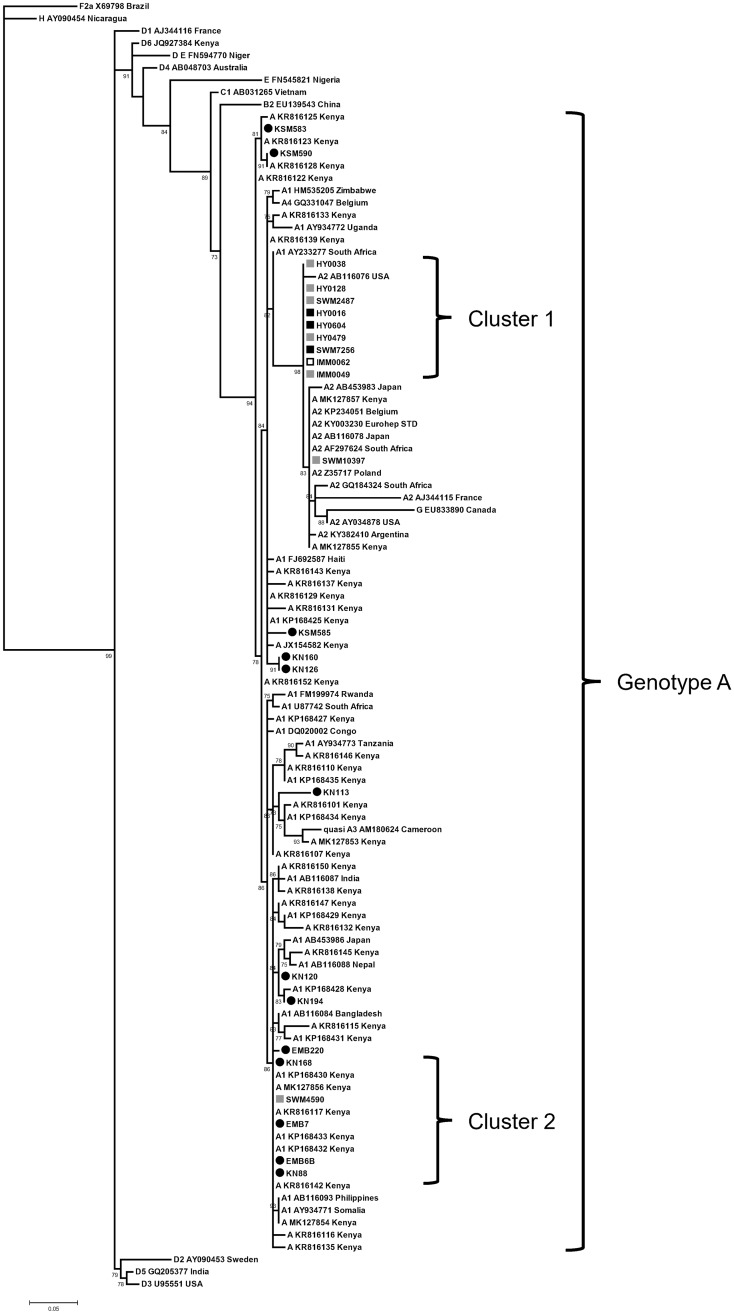
Phylogenetic analysis of the HBsAg-coding region sequence (nt 458–784) from jaundiced OBI, non-MSM OBI, and MSM-SW OBI and HBsAg positive participants.Twenty-four trimmed sequences (327 bp) from 17 OBI (comprising sequences from 1 non-MSM, 3 MSM-SW and 13 jaundiced participants) and 7 HBsAg positive MSM-SW specimens were aligned with GenBank reference sequences and analyzed by maximum likelihood method, using the most fit GTR+γ+I substitution model with the approximate likelihood ratio test for branch support statistics. Reference sequences are shown as a genotype or subgenotype followed by the GenBank accession number and country of origin if available. Two clusters are indicated. Branch support >70% is shown. The ruler shows the branch length for a pairwise distance equal to 0.05. Filled square, MSM-SW OBI sequences; open square, non-MSM OBI sequence; filled circle, jaundiced OBI sequences; grey square, MSM-SW HBsAg positive sequences.